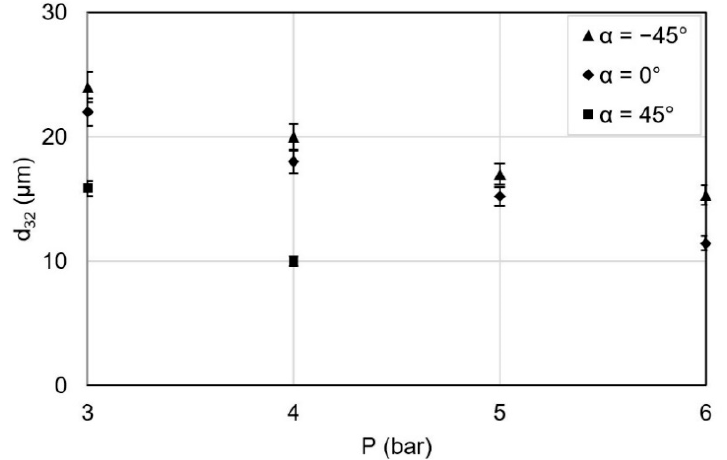
Figure 9. Distribution of droplet diameters d 32 depending on the supply pressure P of the nozzle for X = 500 mm. X = 500